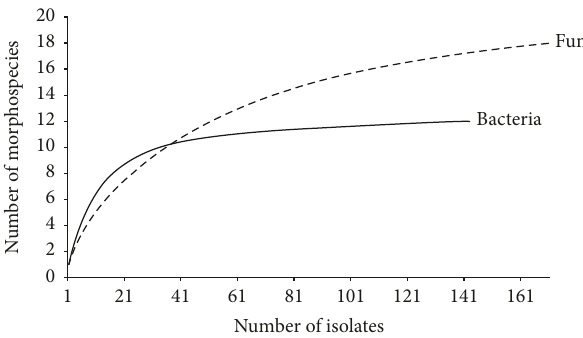
Figure 1: Species accumulation curves for fungal and bacterial morphospecies isolated from female Drosophila melanogaster in Puerto Rico. Species order was randomized 100 times. Fungal and bacterial species are represented with dashed and solid lines,